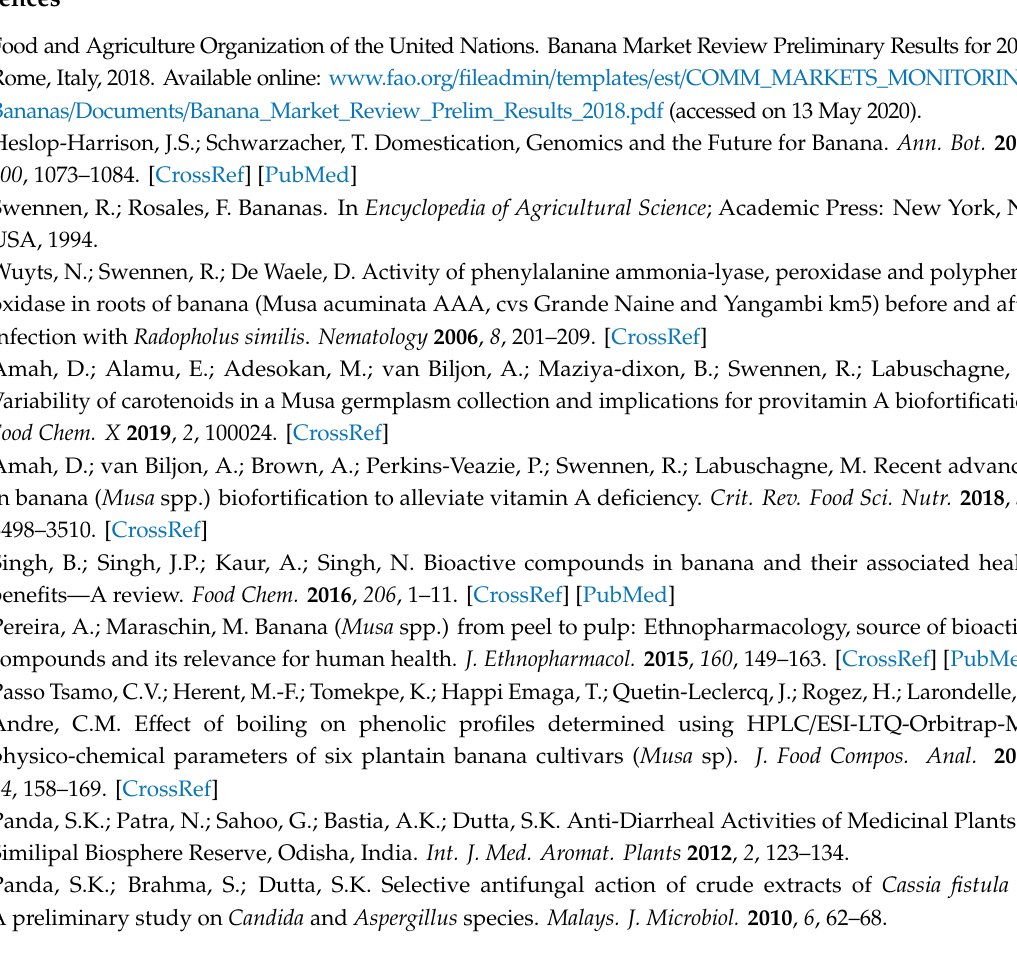
Figure S1: Antiviral activity of extracts against enterovirus; Figure S2: Antiviral activity of extracts against Chikungunya virus; Figure S3: Antiviral activity of extracts against yellow fever virus; Figures S4a–f: TLC of selected extracts (acetone, ethanol, hexane); Figure S4g: Regression curve for gallic acid assayed with the Folin–Ciocalteu reagent. Figures S4h: Distribution of total phenolic content across all samples analysed. Table S1a–d: Rf value of TLC (acetone, ethanol, hexane extracts) Table S1e: Total phenolic content (gallic acid equivalents, µ g / mg) of di ff erent